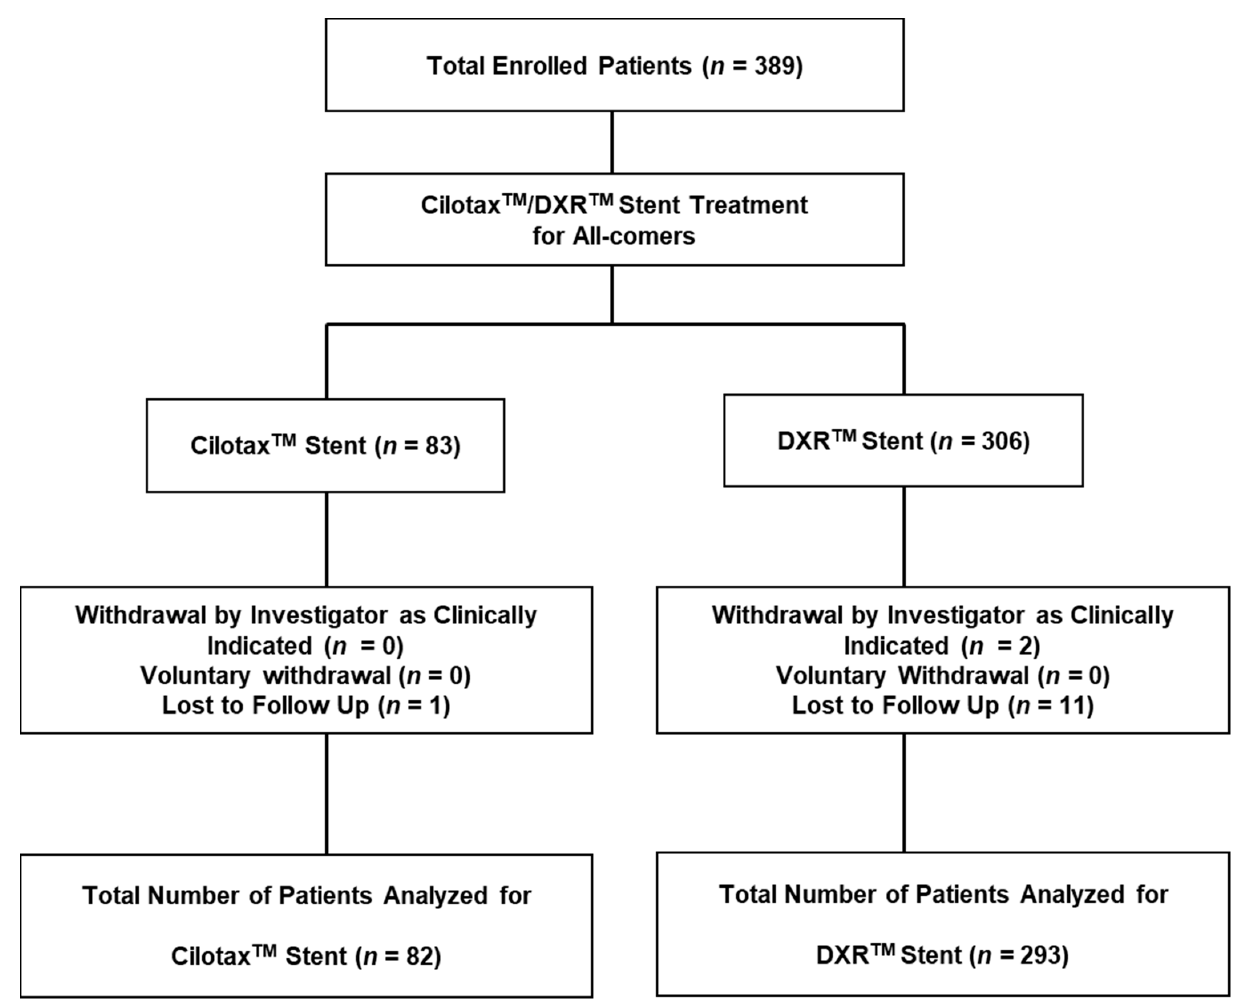
Figure 1. Study flow chart.